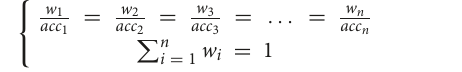
are passed into the total weight controller to get the final